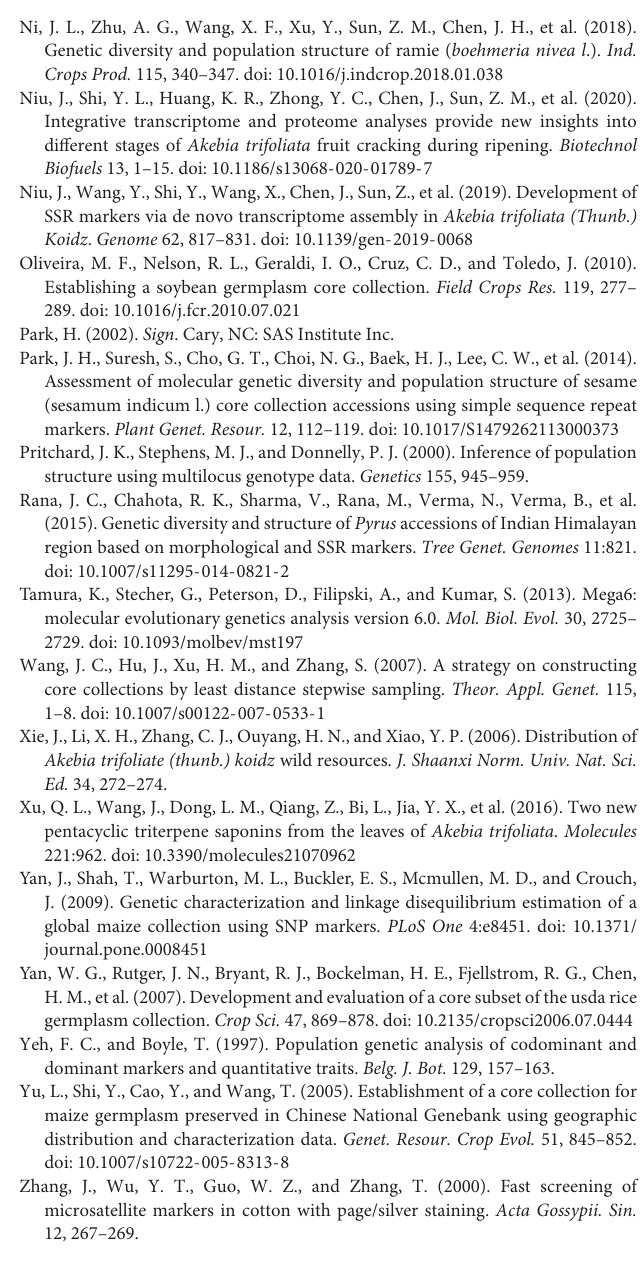
Supplementary Table 1 | Characteristics of 28 SSR primers. Supplementary Table 2 | Molecular identity of the 955 A. trifoliate accessions. Supplementary Table 3 | N a in core collection and random core collection at 28 SSR markers. Supplementary Table 4 | Ho in core collection and random core collection at 28 SSR markers. Supplementary Table 5 | Nei’s in core collection and random core collection at 28 SSR markers. Supplementary Table 6 | PIC in core collection and random core collection at 28 SSR